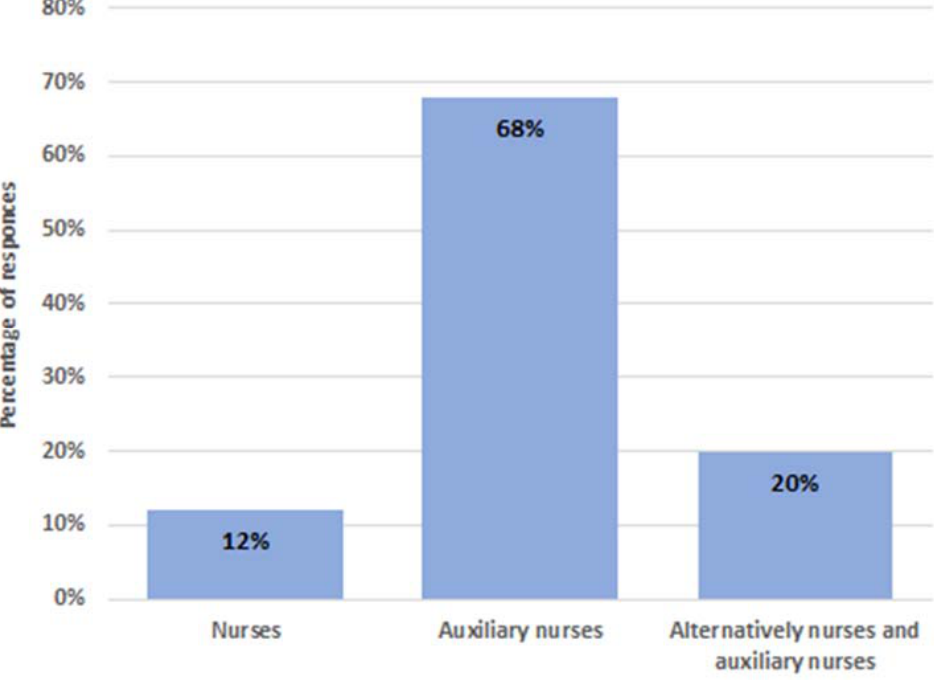
Figure 4. Percentage distribution of all professionals dedicated to reprocessing (40 respondents).